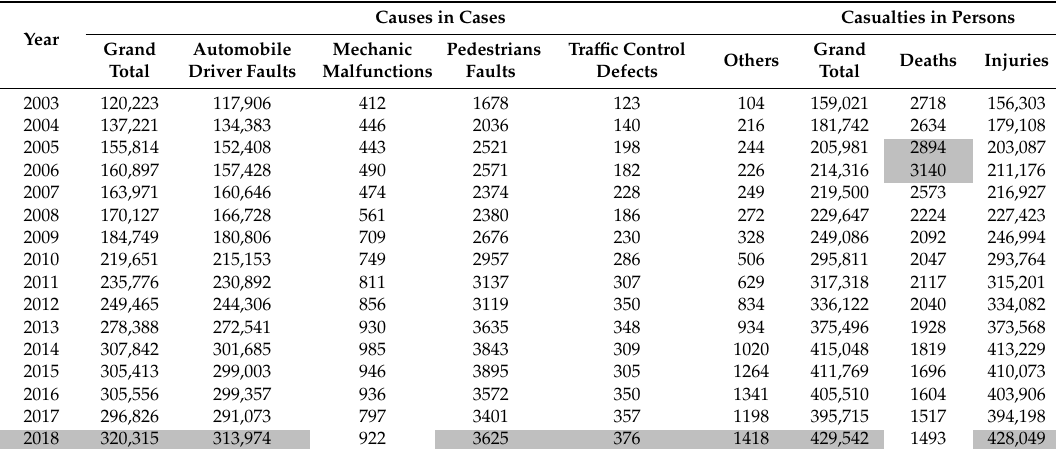
Table 1. Information of causes and casualties of road tra ffi c accidents in